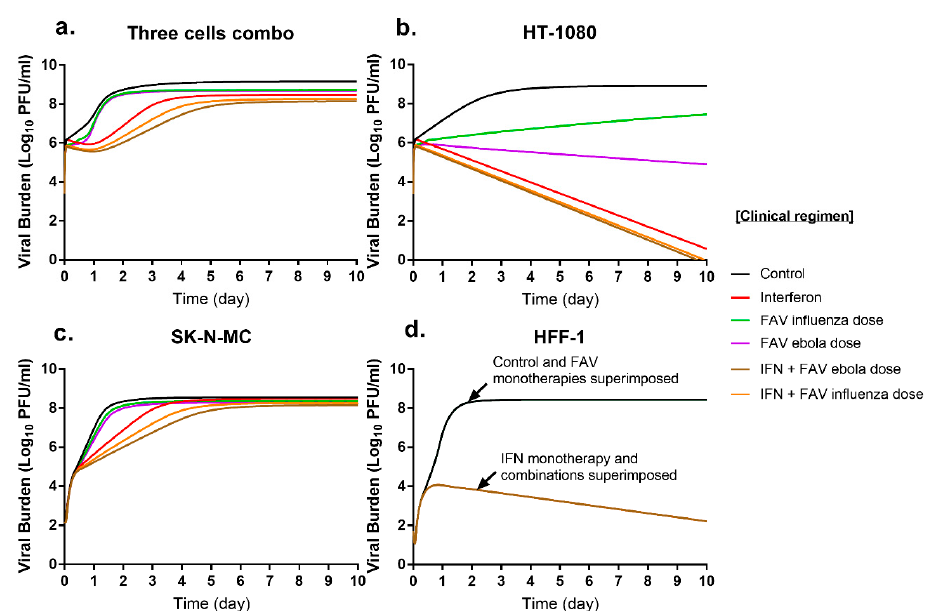
Figure 5. Simulated antiviral activity of clinically relevant FAV and IFN regimens ( a ) in HT-1080 ( b ), SK-N-MC ( c ), HFF-1 ( d ) cells. The PK profiles associated with the IFN clinical regimen of 36 million international units (MIU) twice daily (BID) were used for simulations. FAV influenza regimen of 1800 mg at 0 h and 12 h on day 1 followed by 800 mg BID; and FAV Ebola regimen of 2400 mg at 0 h, 8 h, and 1600 mg at 16 h followed by 1200 mg BID starting on day 2 were utilized for FAV simulations.